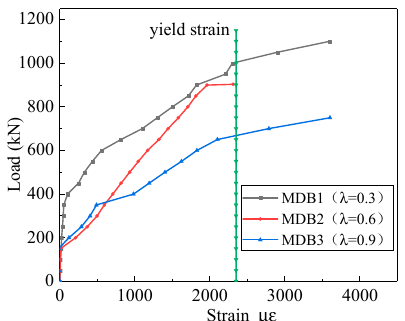
Figure 9. Relation curve between λ and longitudinal reinforcement strain.